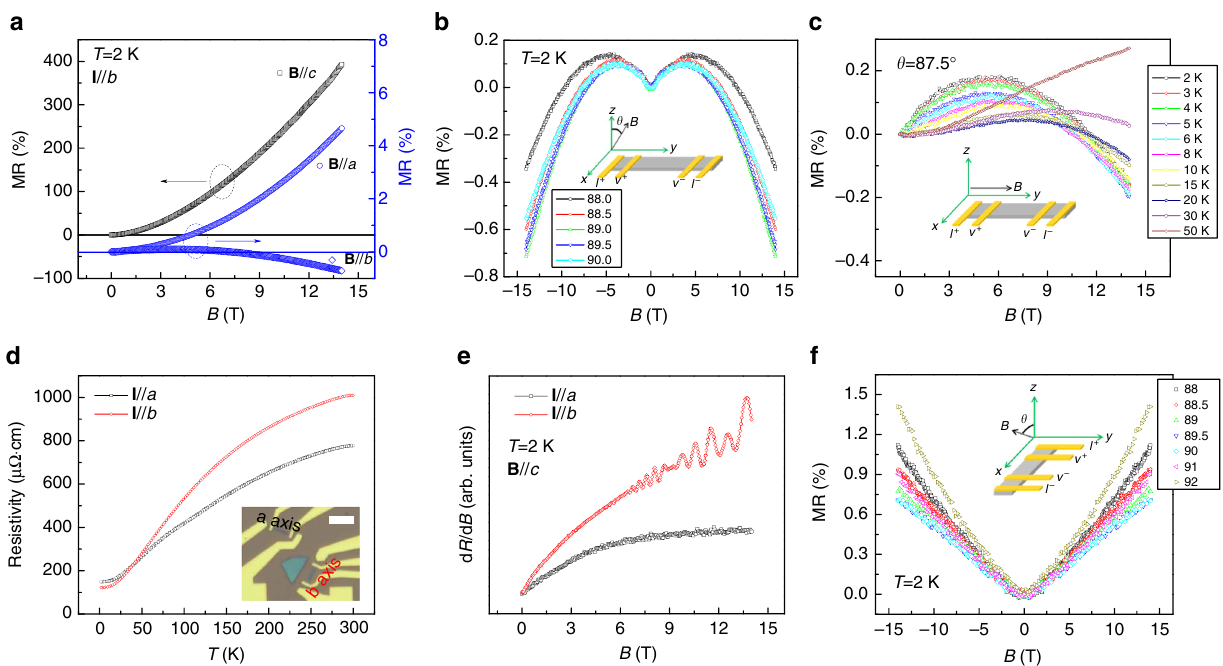
Fig. 3 Chiral-anomaly induced negative longitudinal MR. a MR data obtained along different fi eld directions at 2 K show strong anisotropy in the transport properties. In all of the measurements, I // b in the 19.4 nm thick b -axis ribbon. b The fi eld-dependent, negative and longitudinal MR induced by a chiral anomaly in b -axis ribbon. We note that the occurrence of the maximum negative MR at 89° rather that at 90° could be due to a misalignment when we glued the sample to the sample holder. c The longitudinal MR measured with θ = 87.5° at different temperatures. d The temperature-dependent resistivity of 19.4 nm thick a -axis and b -axis ribbon. The scale bar in the optical image is 5 μ m. e Comparison of quantum oscillation in both ribbons with the magnetic fi eld normal to the ribbon. f The absence of chiral-anomaly-induced negative MR in a -axis